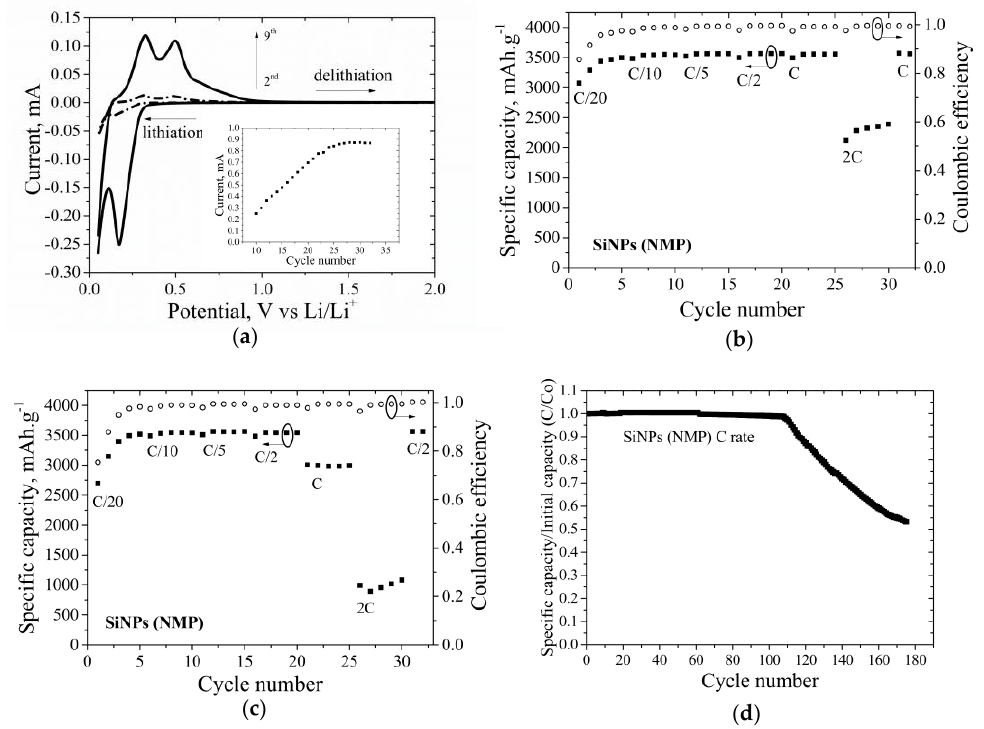
Figure 6. Two-dimensional SiNPs (NMP) electrode: ( a ) Cyclic voltammograms: second cycle (dotted curve) and ninth cycle (bold curve). Inset: Peak intensity of the cathodic peak (at potential 0.17 V) related to the lithiation of Si; ( b ) Galvanostatic profile of specific capacities (square dot) and coulombic efficiency (circle dot) at different densities for an electrode mass of 34 µ g · cm − 2 and ( c ) for an electrode mass of 60 µ g · cm − 2 ; ( d ) Galvanostatic profile of specific capacities divided by the initial capacity at 1 C rate.